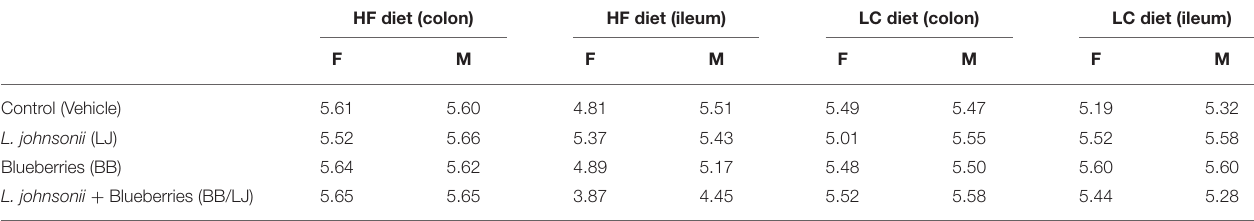
TABLE 2 | Alpha diversity of stool samples collected from colon and ileum after different treatments, expressed by Shannon Index. HF diet (colon) HF diet